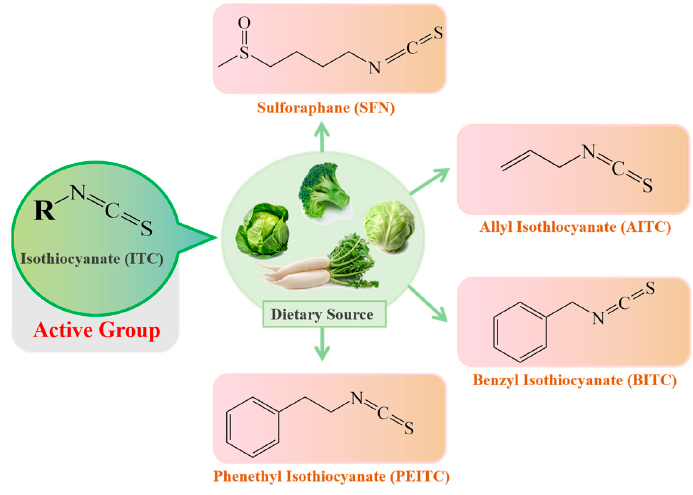
Figure 2. The dietary source and basic structure of ITCs.